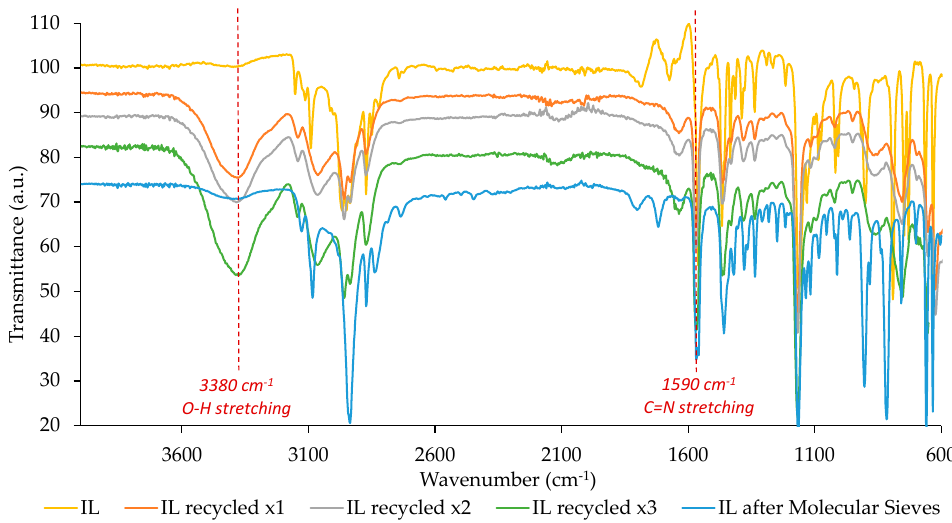
Figure 7. FTIR-ATR spectra of pure IL (yellow line), recycled IL (x1 orange line, x2 grey line, x3 green line), and recycled and treated with molecular sieves IL (blue line).